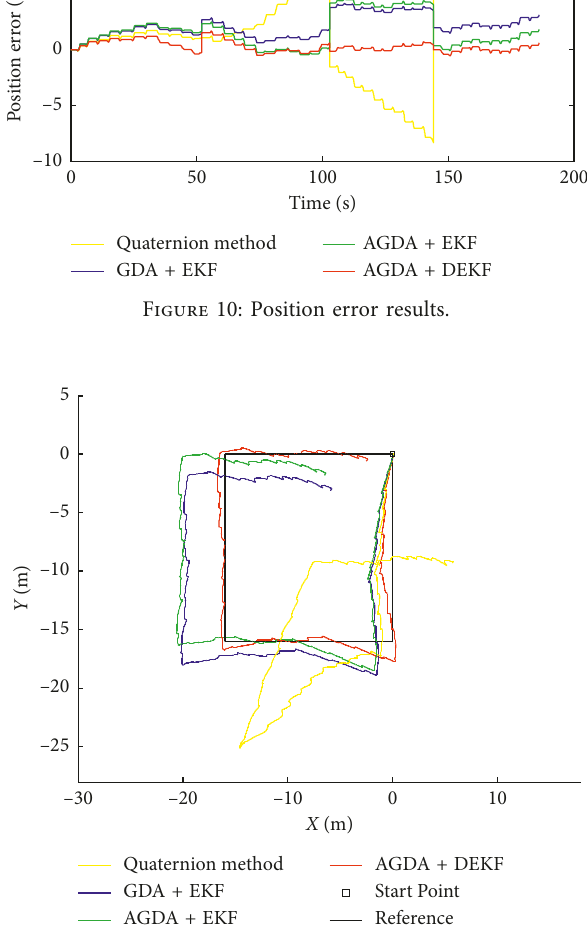
Figure 11: Contrast results of